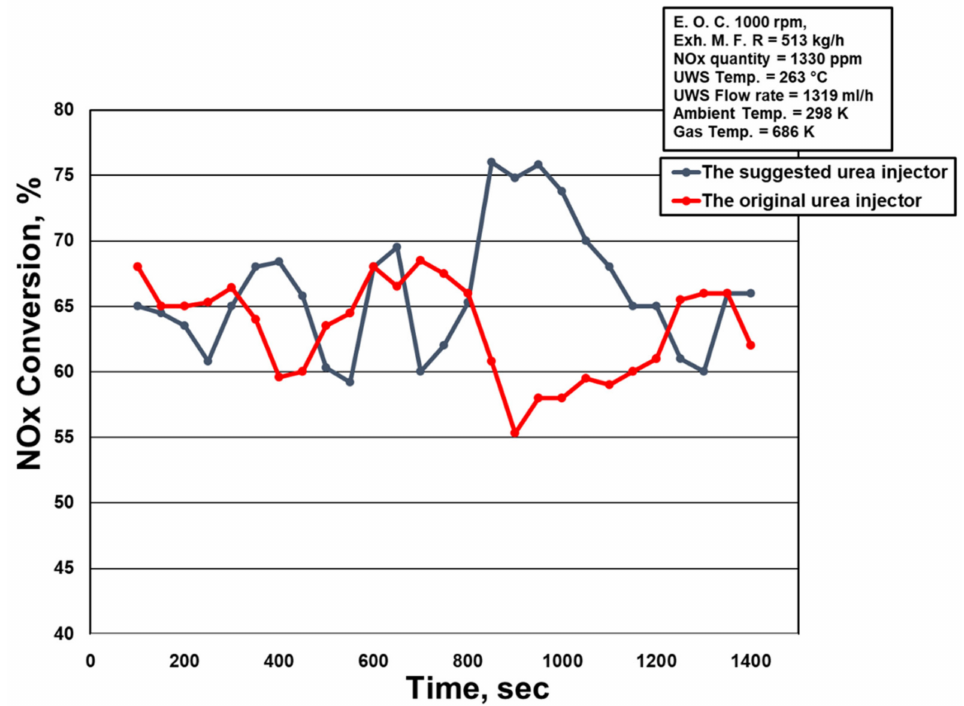
Figure 9. NOx conversion value by MEXA-7100 gas